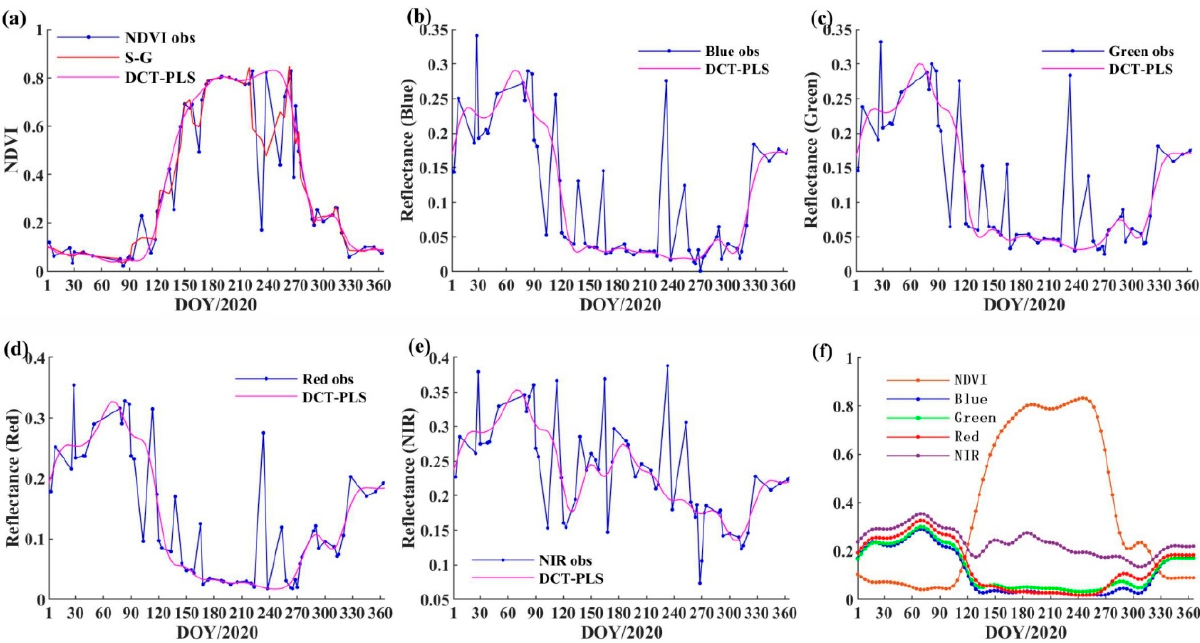
Figure 4. The comparison of NDVI and band reflectance time series from Sentinel-2, the DCT-PLS and SG filter methods for the larch sample in 2020. ( a ) The NDVI time series; ( b – e ) The surface reflectance time series in blue, green, red and NIR band, respectively; ( f ) The reconstructed NDVI and all the band reflectance time series from the DCT-PLS method.